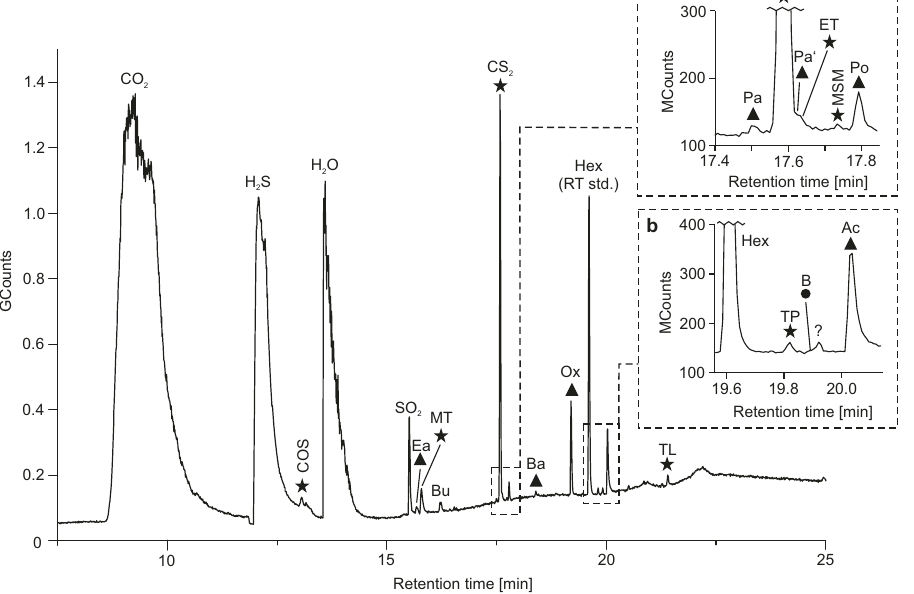
Fig. 4 Total ion current chromatogram of volatile compounds from black barite fl uid inclusions as detected by thermal decrepitation/desorption GC – MS (TD-GC – MS) analysis at 250 °C. Inserts a , b represent enlargements of respective areas in the chromatogram marked by dashed lines. Triangles denote oxygen-bearing compounds, circles denote aromatic hydrocarbons and stars denote sulfur-bearing compounds. n -Hexane (Hex) was used as a retention time standard (RT std.). COS carbonyl sul fi de, Ea ethanal, MT methanethiol, Bu but-1-ene, Pa prop-2-enal, Pa ’ propanal, ET ethanethiol, MSM (methylsulfanyl)methane, Po propan-2-one, Ba but-2-enal, Ox oxolane, TP thiophene, B benzene, Ac acetic acid, TL thiolane. Note the presence of methanethiol and acetic acid, the stable building blocks of activated acetic